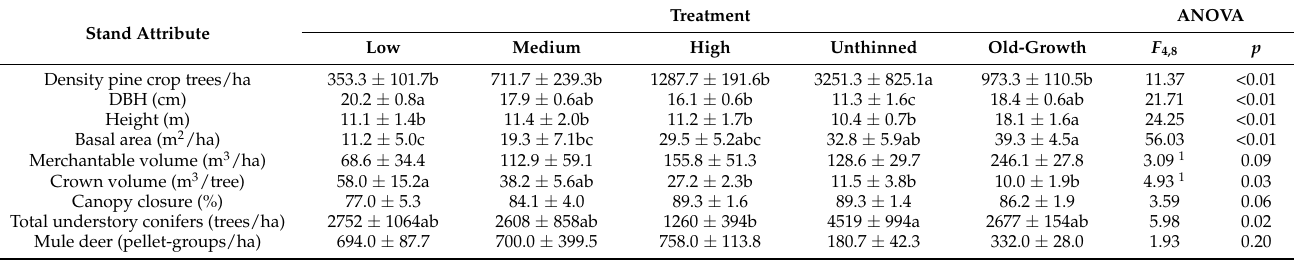
Table 2. Mean ( n = 3 replicate sites) ± SE 20- to 25-year responses of overstory crop trees and understory conifer attributes for lodgepole pine stands with three post-thinning (PCT) densities, unthinned, and old-growth treatments. Results of analysis of variance (ANOVA) are also provided. Within a row, mean values with different letters (a, b, or c) are significantly different by Duncan’s multiple range test. Significant values in bold text. Stand